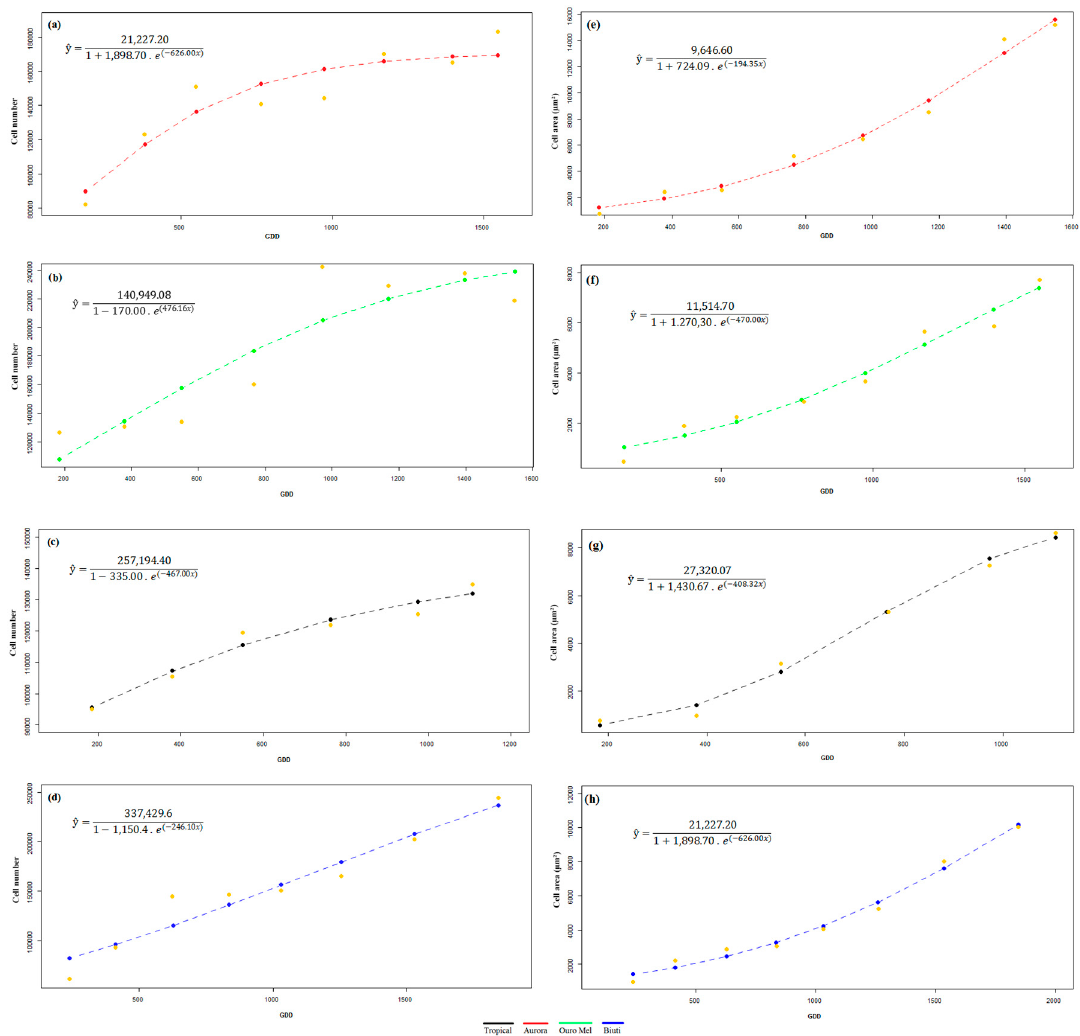
Figure 4. Growth curves observed and fitted for the cell number (CN) and cell area (CA) of ‘Aurora-2’ ( a , e ), ‘Ouro Mel-4’ ( b , f ), ‘Tropical’ ( c , g ) and ‘Biuti’ ( d , h ), according to the logistic model.